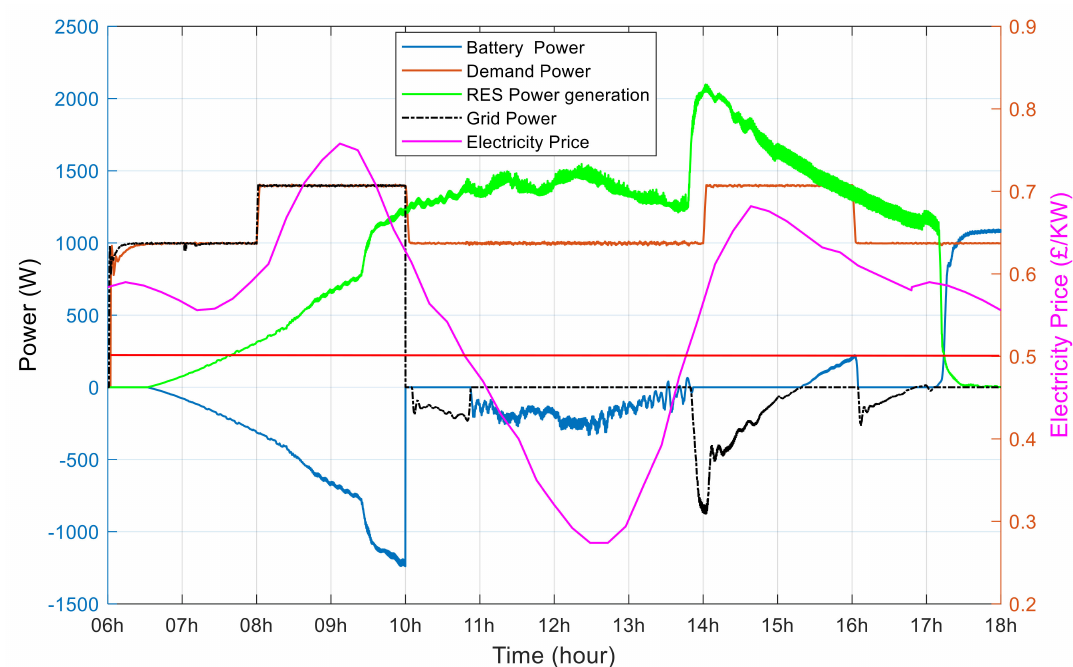
Figure 10. Energy management scenarios based on GPC model controller for the grid-connected mode and static set